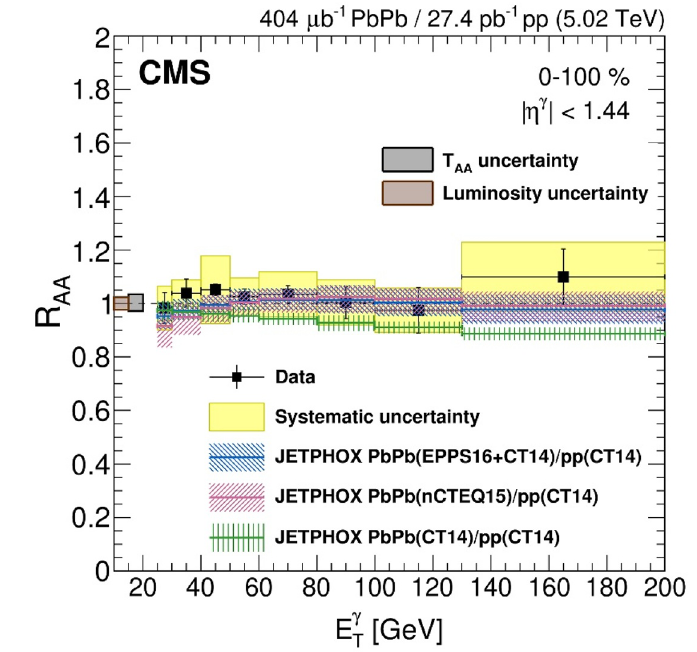
Figure 6 . Nuclear modi(cid:12)cation factors R as a function of the photon E g measured in the AA T 0{100% centrality range in PbPb. The symbols are placed at the center of the bin. The vertical bars indicate the statistical uncertainties and the horizontal bars re(cid:13)ect the bin width. The total systematic uncertainties without the T uncertainty are shown by the colored boxes. The 3.4% AA T uncertainty, common to all points, is indicated by the gray box centered at unity on the AA left side of the panel. The luminosity uncertainty of the pp data is shown as the brown box at unity at the leftmost position. The three di(cid:11)erent NLO jetphox calculations of EPPS16+CT14 nPDFs, nCTEQ15 nPDFs, and CT14 PDFs for PbPb collisions are divided by the NLO jetphox calculations with CT14 PDFs for pp collisions, and compared to the data. The hatched boxes correspond to jetphox (n)PDF